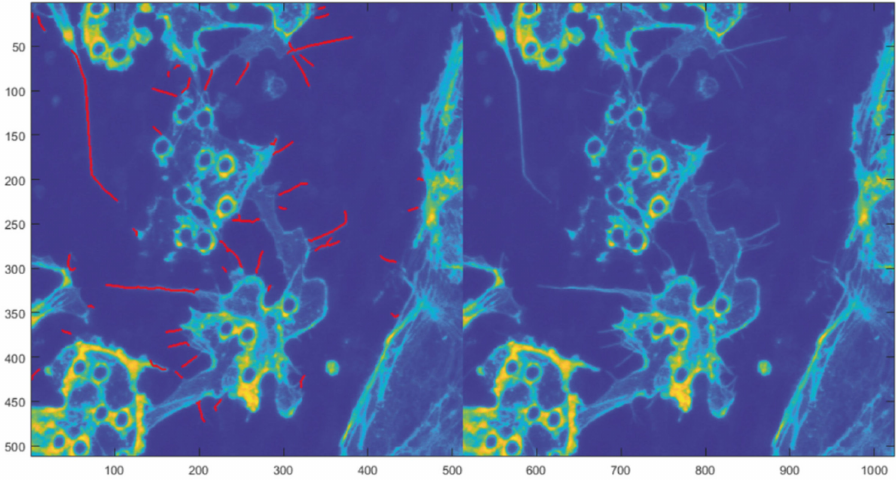
Figure A2. Semi-automatic filopodia detection on fixed samples. Filopodia detection (red) for the right image (average z projection of the bottom